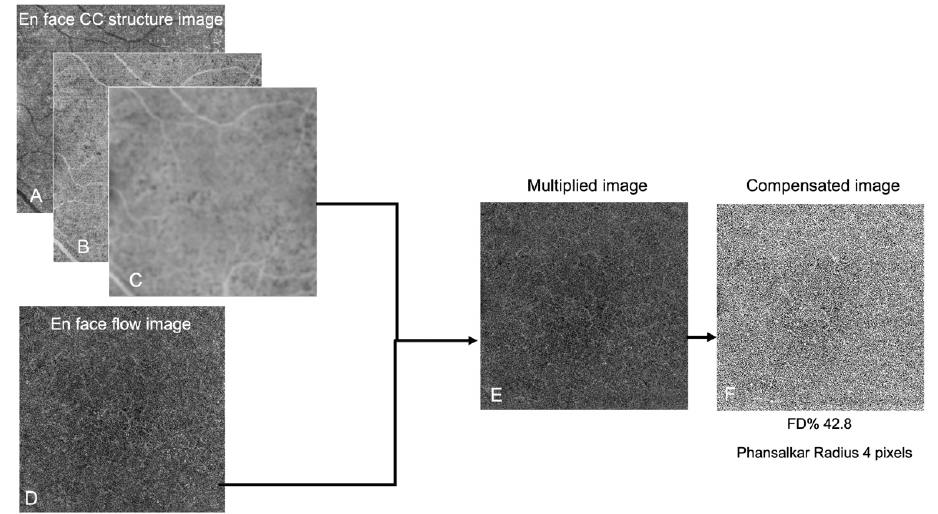
Figure 2. The image processing method used to investigate the choriocapillaris flow. En-face choriocapillaris (CC) structure image ( A ) underwent an inverse transformation using the Fiji “Invert” function ( B ). Next, smoothing was obtained using a Gaussian blur filter ( C ). Next, multiplication between the en-face CC flow image ( D ) and the processed en-face CC structure image ( C ) was performed using the “Image Calculator” ( E ). After multiplication between the en-face CC flow image and the processed en-face CC structure, a compensated en-face CC image was generated by Fiji ( F ). In this example, the compensated en-face CC flow image binarization was performed using a Phansalkar Radius of 4 pixels. The flow deficit percentage (FD%) was 42.82%. The main outcome measures are the percentage of FD (FD%), the number and size of FD, and the total FD area. The number of FDs was the number of contiguous black pixels representing the FDs. The size of FDs was the mean area in μm 2 of the contiguous black pixel area. Total FDs area represents the area in μm 2 of all the FDs. FD% was computed